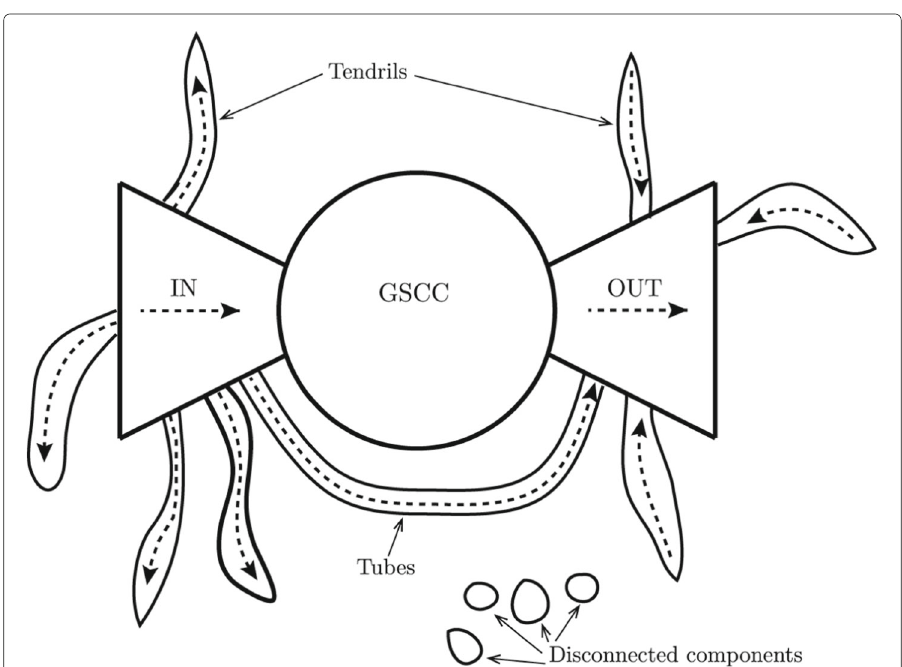
Fig. 1 The schematic bow-tie structure of the web graph